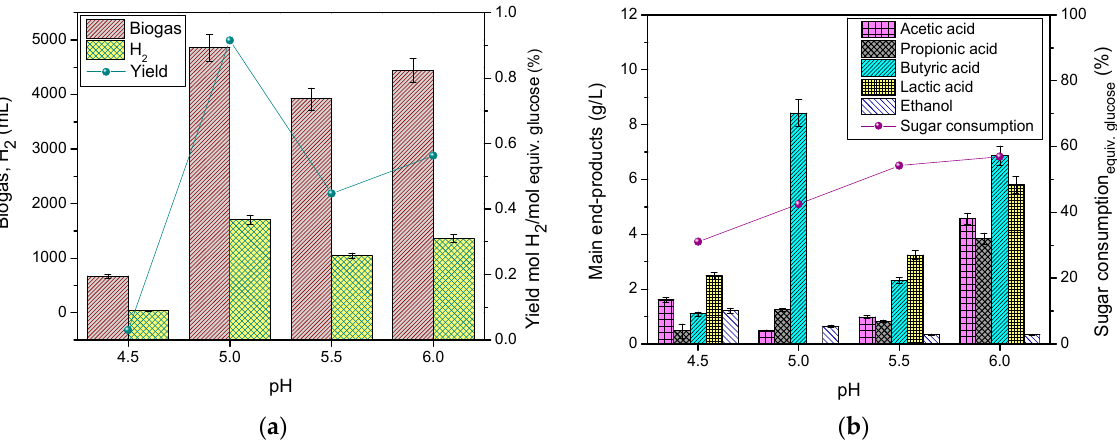
Figure 1. Effect of pH on ( a ) biogas and hydrogen production and hydrogen yield and ( b ) main soluble end products and carbohydrate consumption. The values correspond to mean ± standard deviation of batch tests conducted in duplicate.